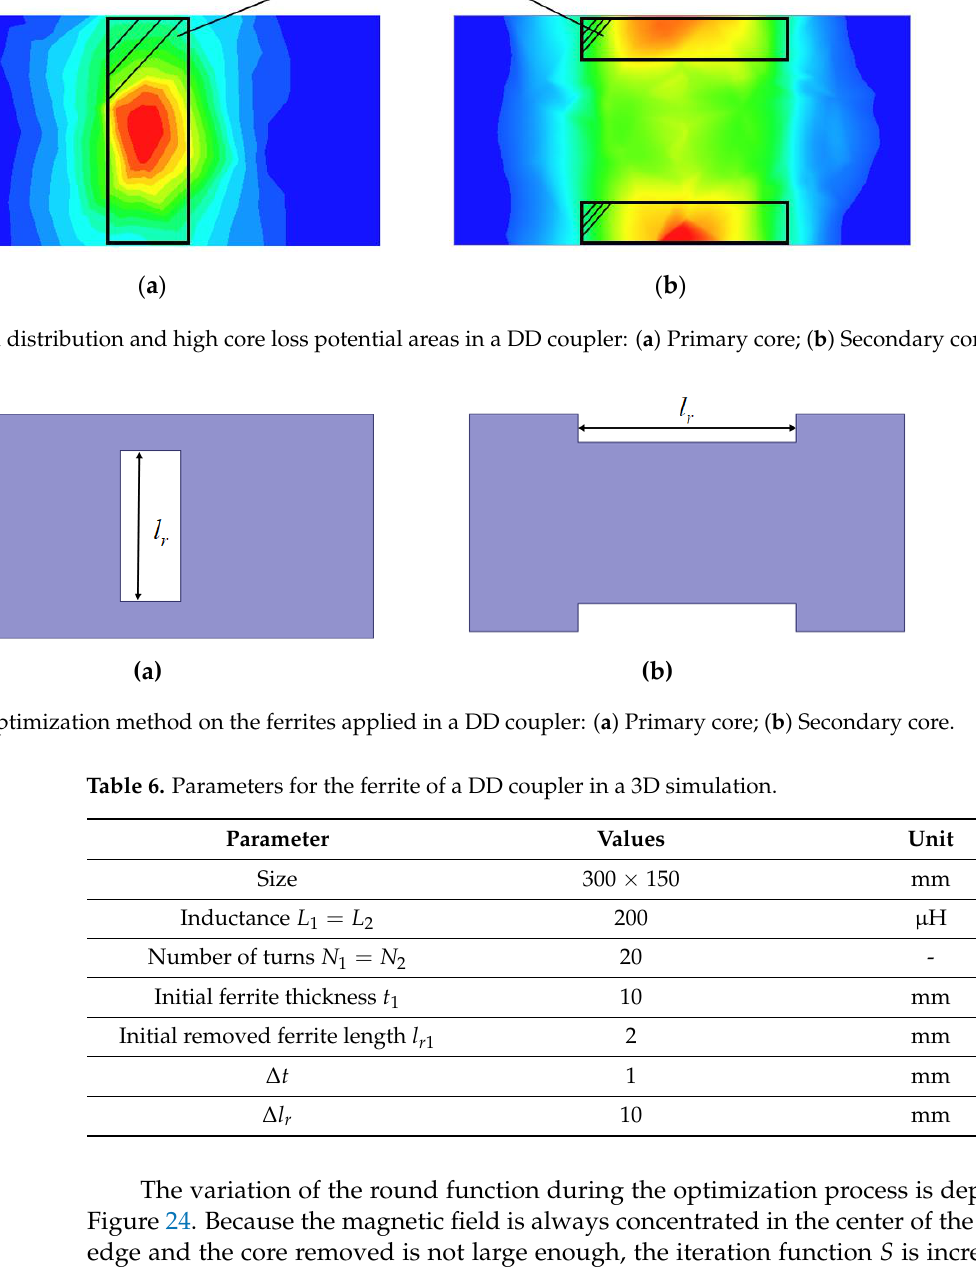
Energies 2021 , 14 , x FOR PEER REVIEW